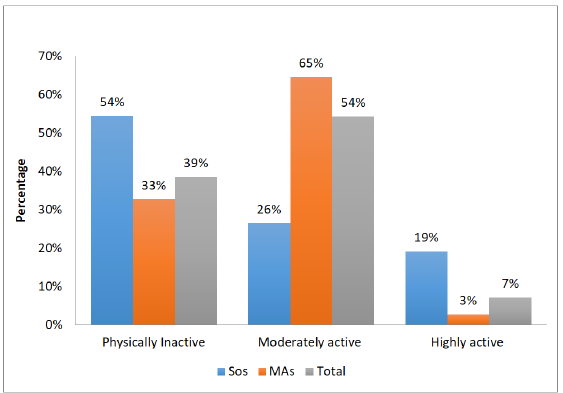
Figure 3. Physical activity levels in the